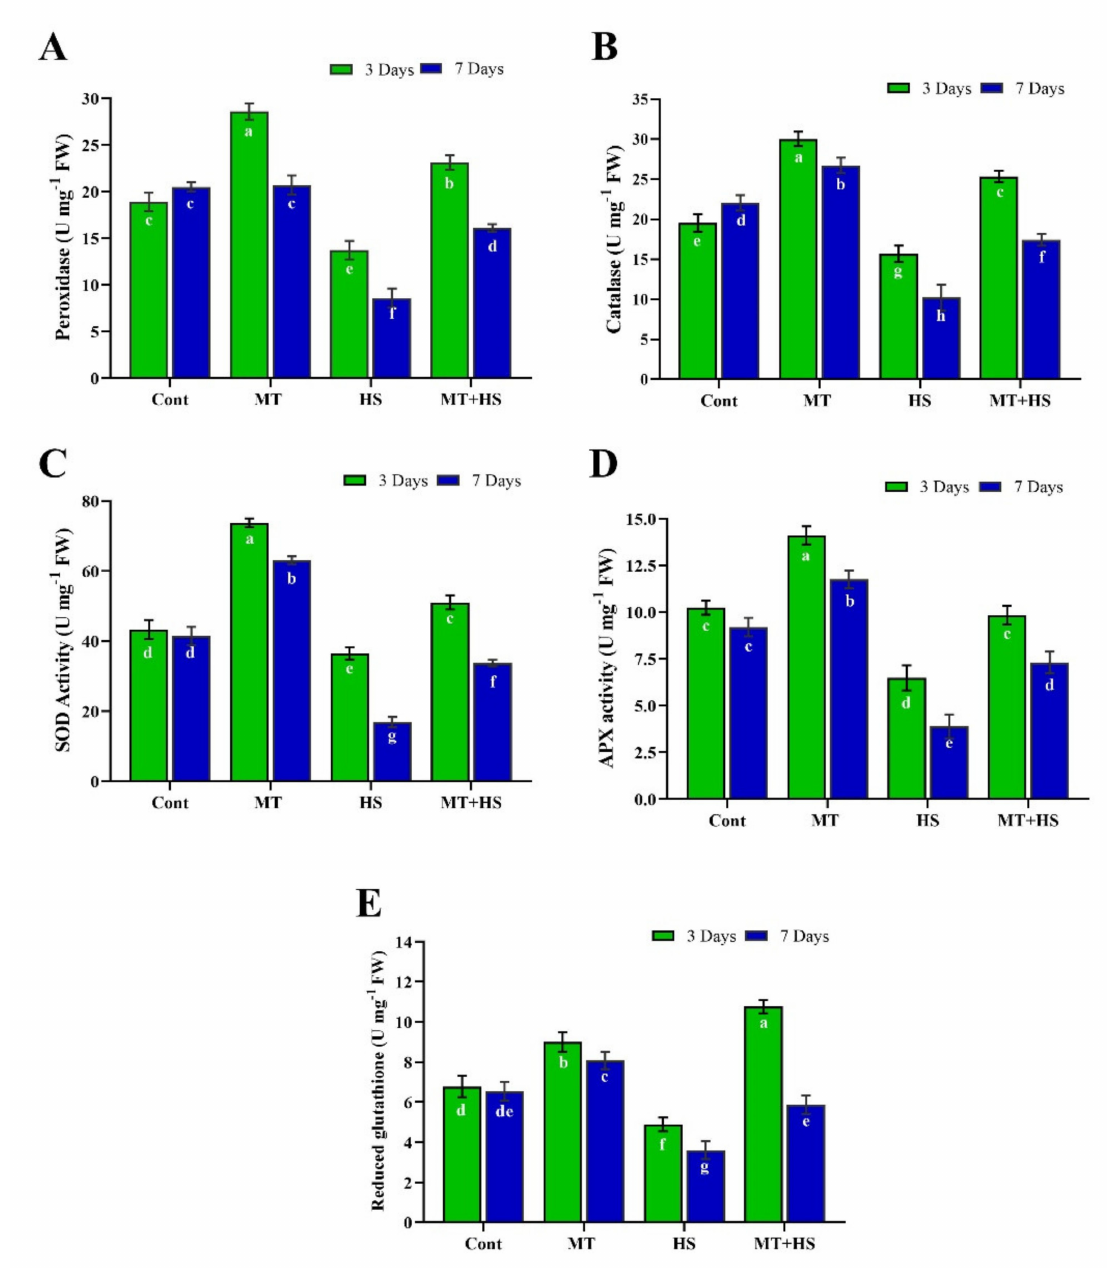
Figure 2. Effects of melatonin application with or without high temperature (42 ◦ C) on antioxidant enzyme activities of ( A ) peroxidase, ( B ) catalase, ( C ) superoxide dismutase ( D ) APX activity, and ( E ) reduced glutathione in soybean seedling after 3 and 7 days. Each data point is the mean of three replicates. Error bars represent the standard error of the mean. Bars with different letters are significantly different from each other by Duncan’s multiple range test at p ≤